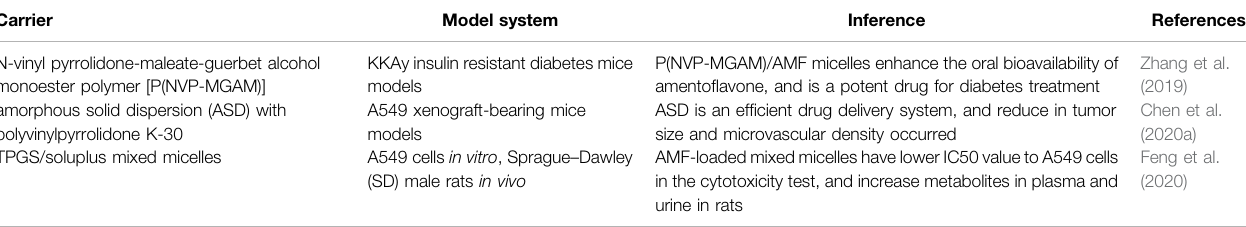
TABLE 5 | various drug delivery carriers containing amento fl